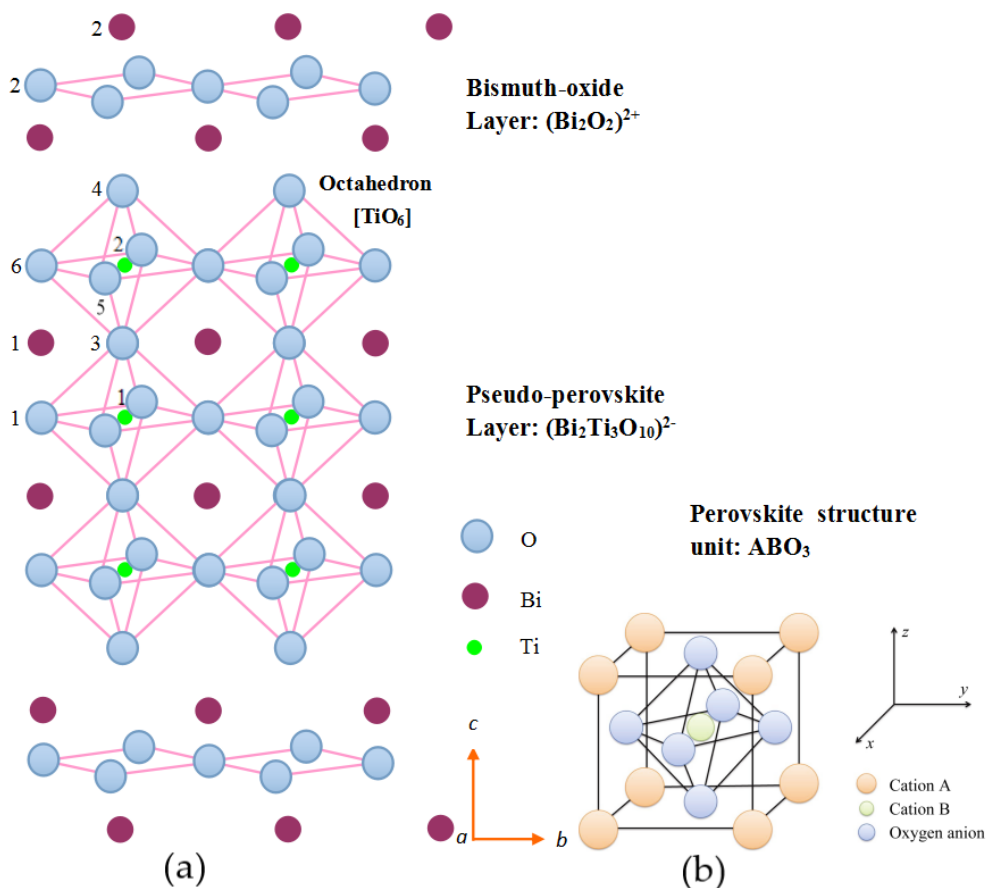
Figure 1. ( a ) A perspective drawing of Bi 4 Ti 3 O 12 along [110] of the undistorted Fmmm parent structure (between c /4 and 3 c /4 of unit cell); ( b ) A schematic sketch of perovskite structure unit.